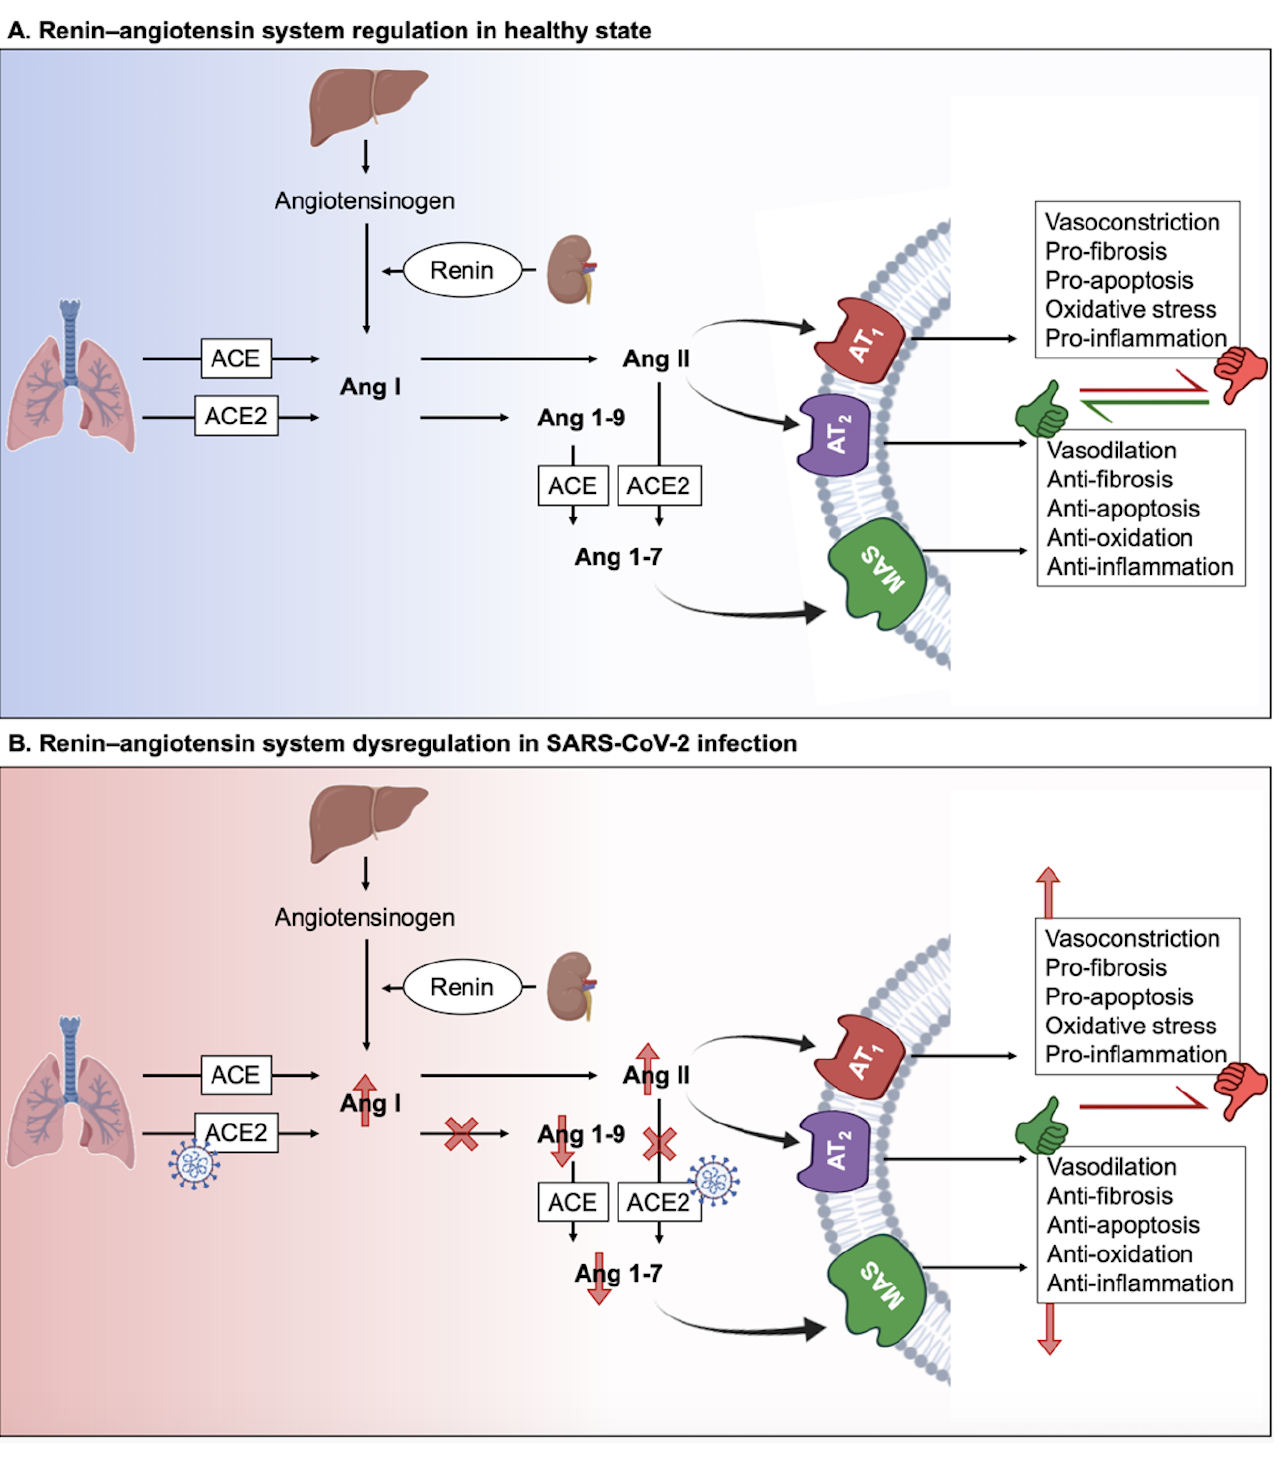
Figure 1. Schematic of RAS homeostasis (A) and impairment during SARS-CoV-2 infection (B). ACE: Angiotensin-converting enzyme; Ang: Angiotensin; AT1R: Angiotensin II receptor type-1; AT2R: Angiotensin II receptor type-2; MAS: Mas-related G protein-coupled receptors. The imbalance of RAS in COVID-19, via the virus-mediated down-regulation of ACE2, favorizes the pro-inflammatory ACE/Ang II/AT1R axis leading to the cytokine storm